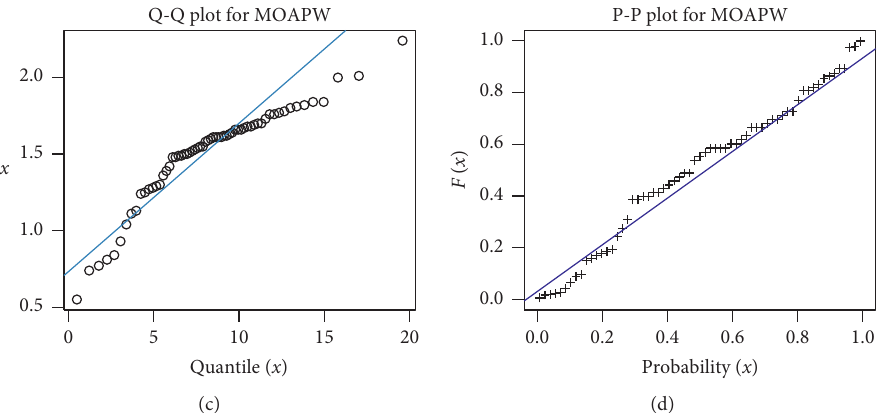
Figure 7: Cumulative function, empirical CDF, PDF, Q-Q, and P-P plots for the MOAPW distribution for the second data